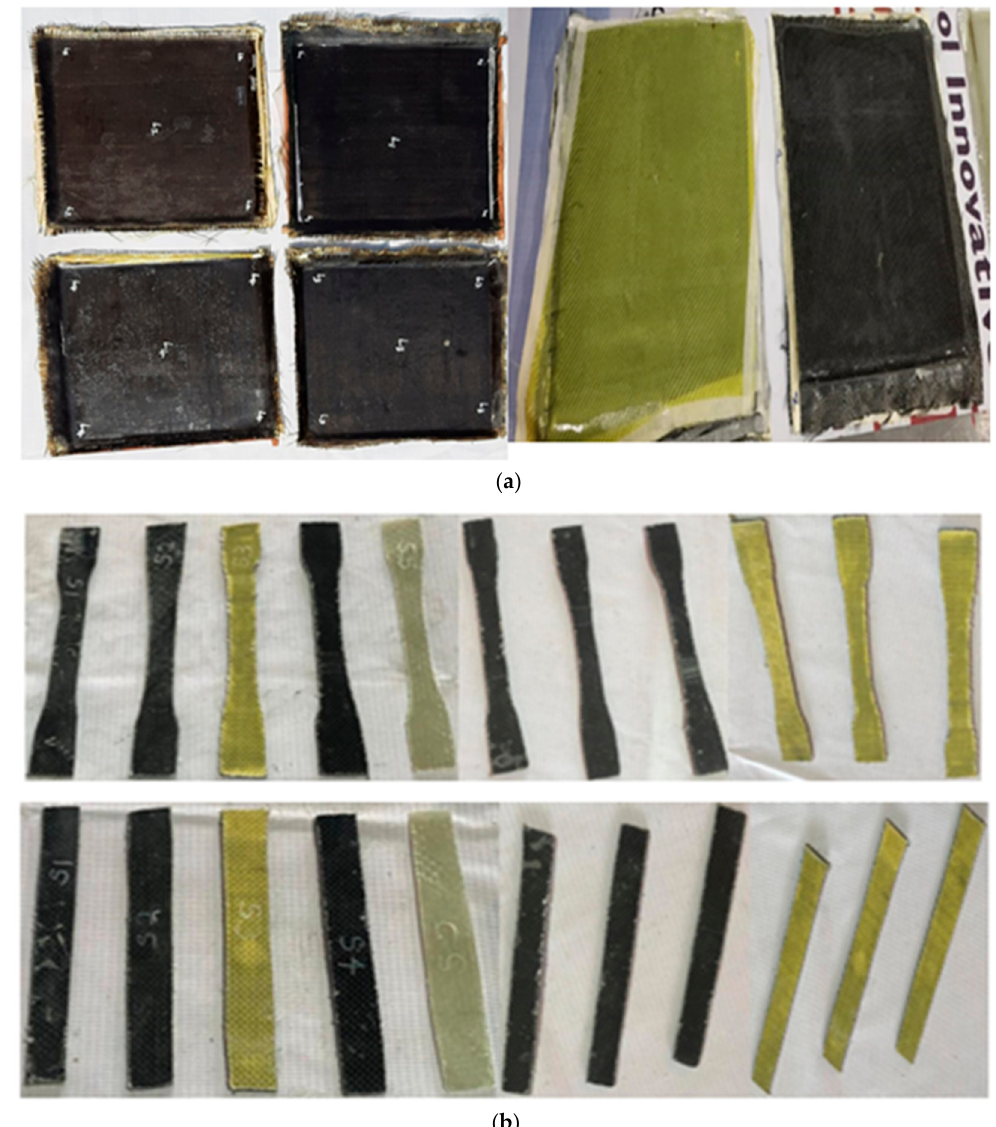
Figure 3. Preparation of composite materials using the vacuum bag infusion technique.